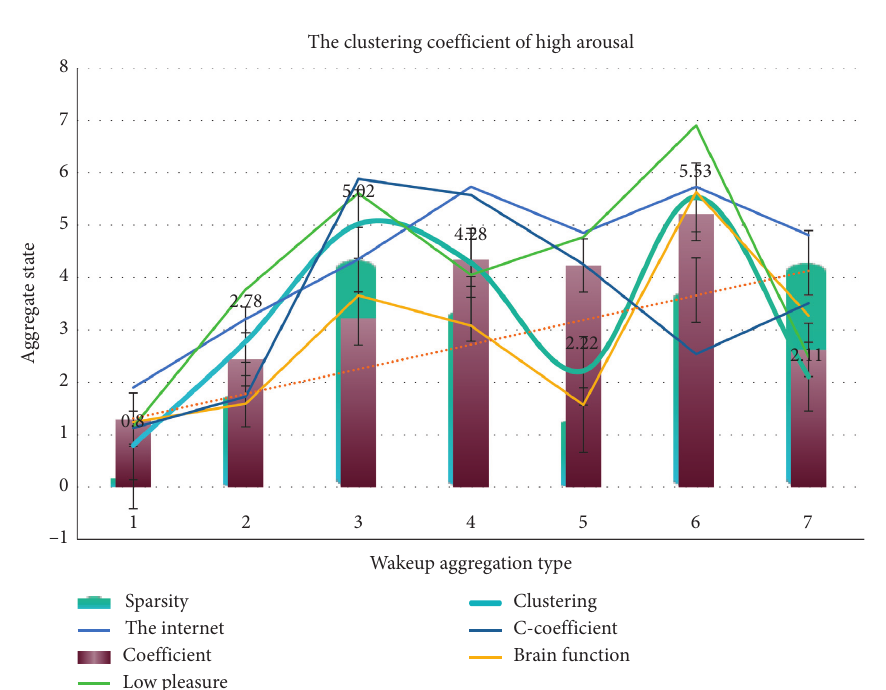
Figure 4: the clustering coefficient of high